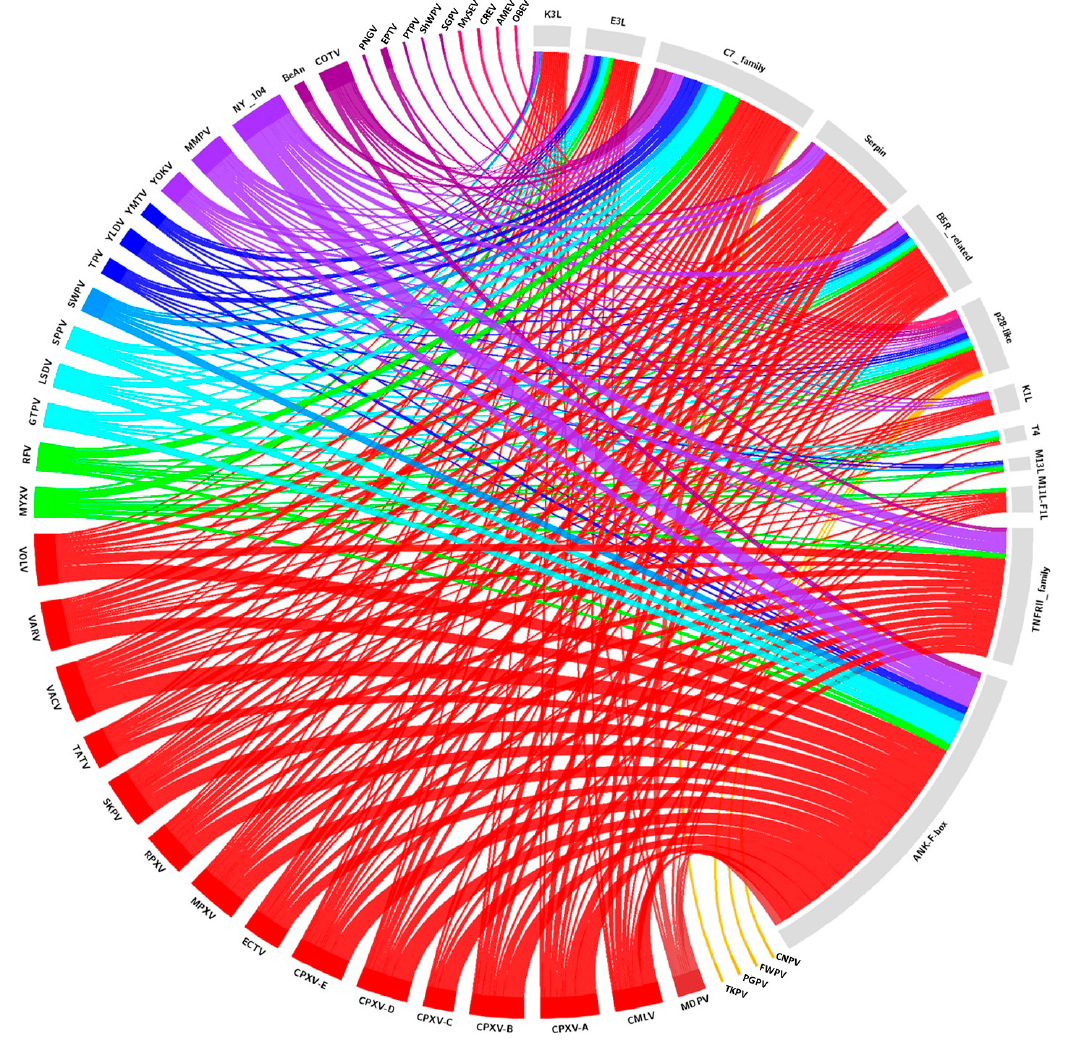
Figure 2. Circos plot representing the amount and diversity of host range genes among the poxviruses. Genomic information was available at the NCBI database, following the established criteria (E-value ≤ 0.0001; Ident ≥ 30%; Coverage ≥ 40%). The different colors stand for the genus of poxviruses and the family of host range genes. The full names of the viruses are listed in Supplementary Table S1.